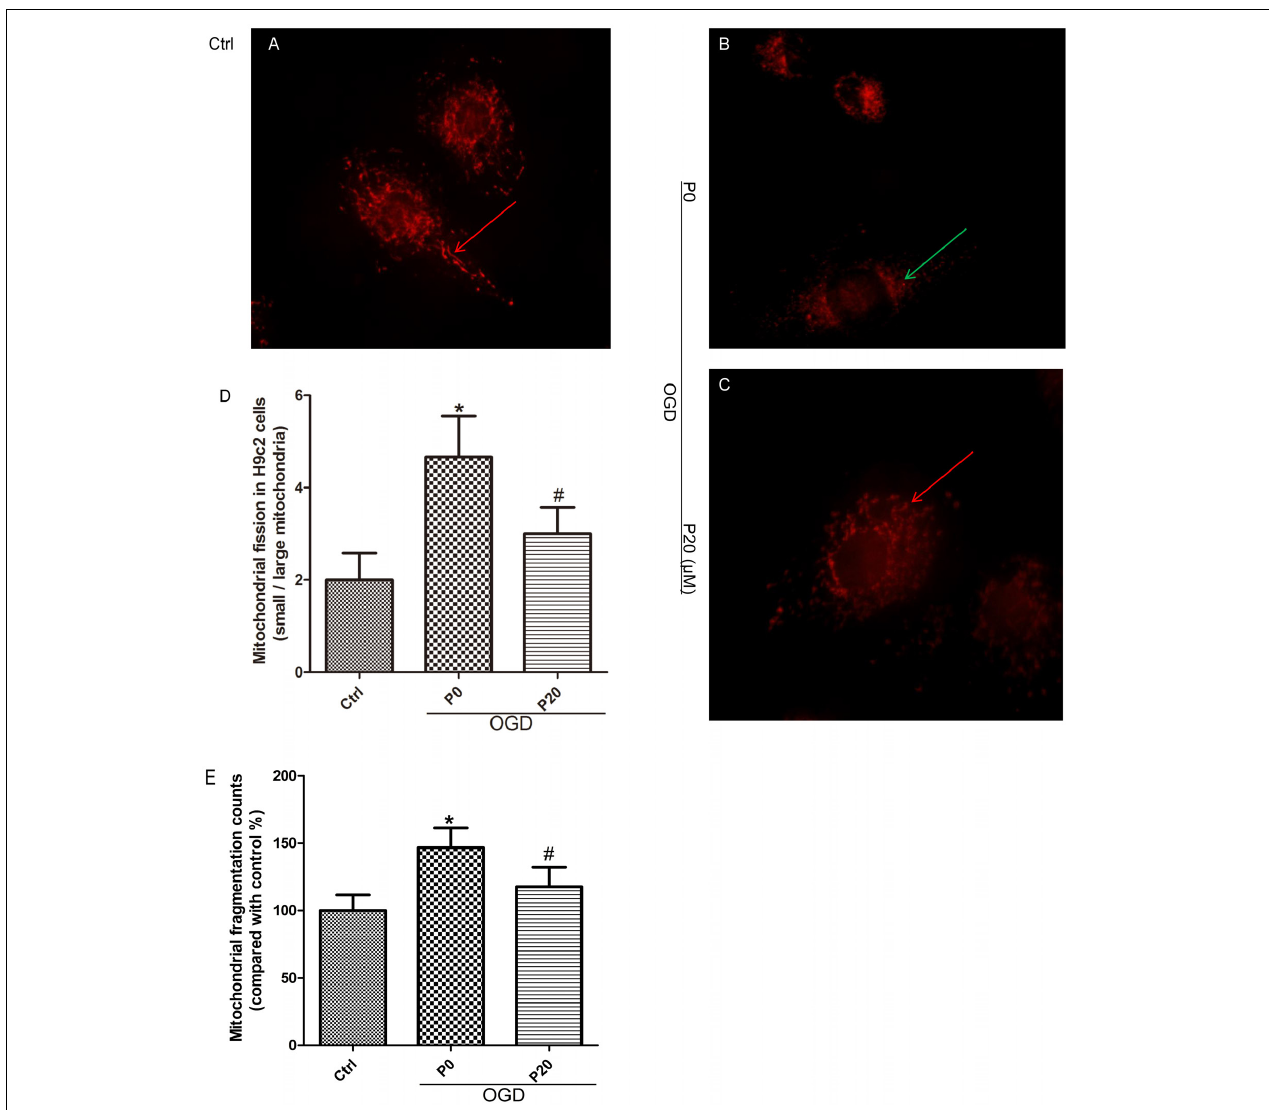
FIGURE 3 | Propofol inhibited mitochondrial fission in H9c2 cells during OGD injury. (A,B,D,E) Compared with control group, small mitochondria (green arrows) increased in H9c2 cells during OGD injury. Scale bar: 10 µ m. (B–E) Propofol increased the quantity and proportion of large mitochondria (red arrows) in H9c2 cells during OGD injury. The data are presented as the mean ± SD of at least three independent experiments. ∗ P < 0.05 versus control, # P < 0.05, versus OGD group without